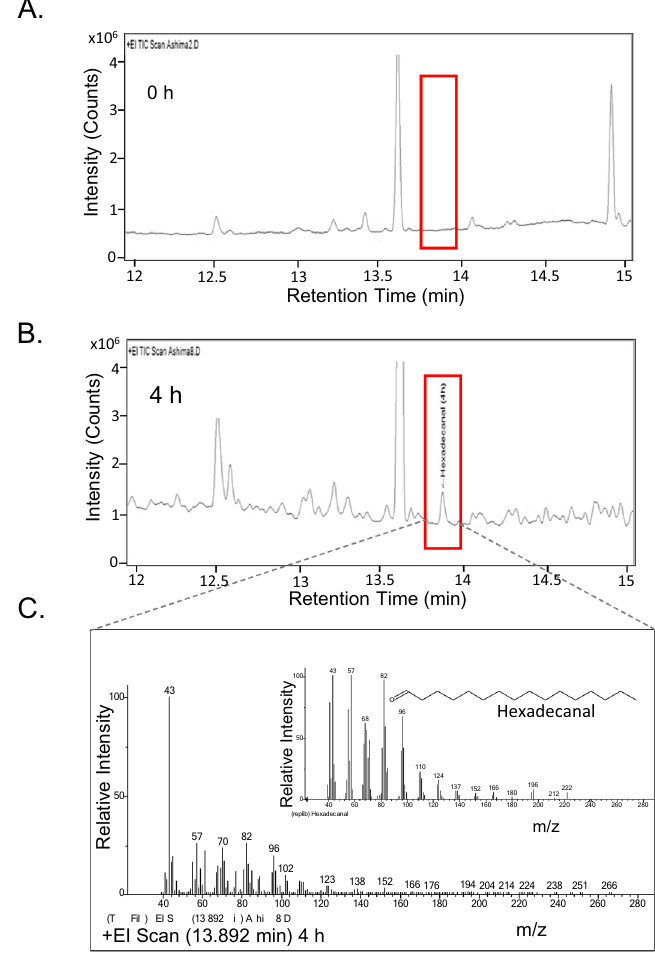
Figure 2. Enzymatic activity assay of AAR. Panels represent Total Ion Current (TIC) chromatogram probed by Gas Chromatography-Mass spectrometry (GC–MS) of the analyzed reaction product (hexadecanal) at different time intervals 0 h ( A ) and 4 h ( B ). ( C ) Mass spectrum of the peak corresponding to hexadecanal, Inset represents the mass spectrum of the hexadecanal from the database